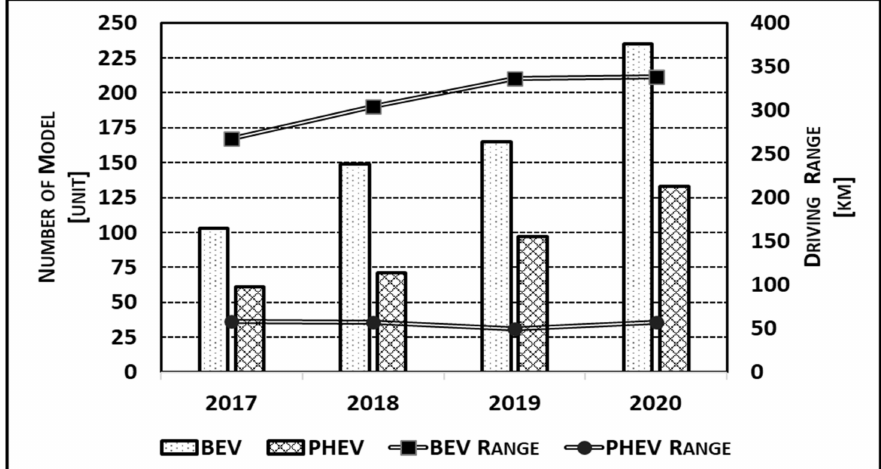
Figure 11. Available global EV models and average